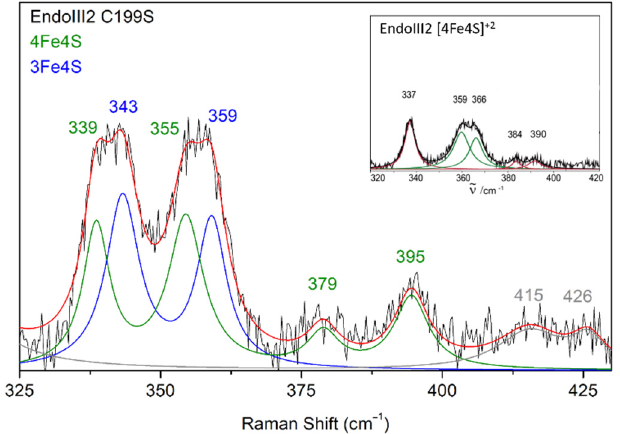
Figure 8. Experimental RR spectrum of DrEndoIII2 C199S in the resting state obtained using 413 nm excitation (black trace) and its component spectrum with designated vibrational modes that originate from 4Fe-4S (green trace) and 3Fe-4S clusters (blue trace). Inset RR spectrum of DrEndoIII2 native enzyme that possesses only 4Fe-4S cluster (adapted from [17] with permission from Elsevier).